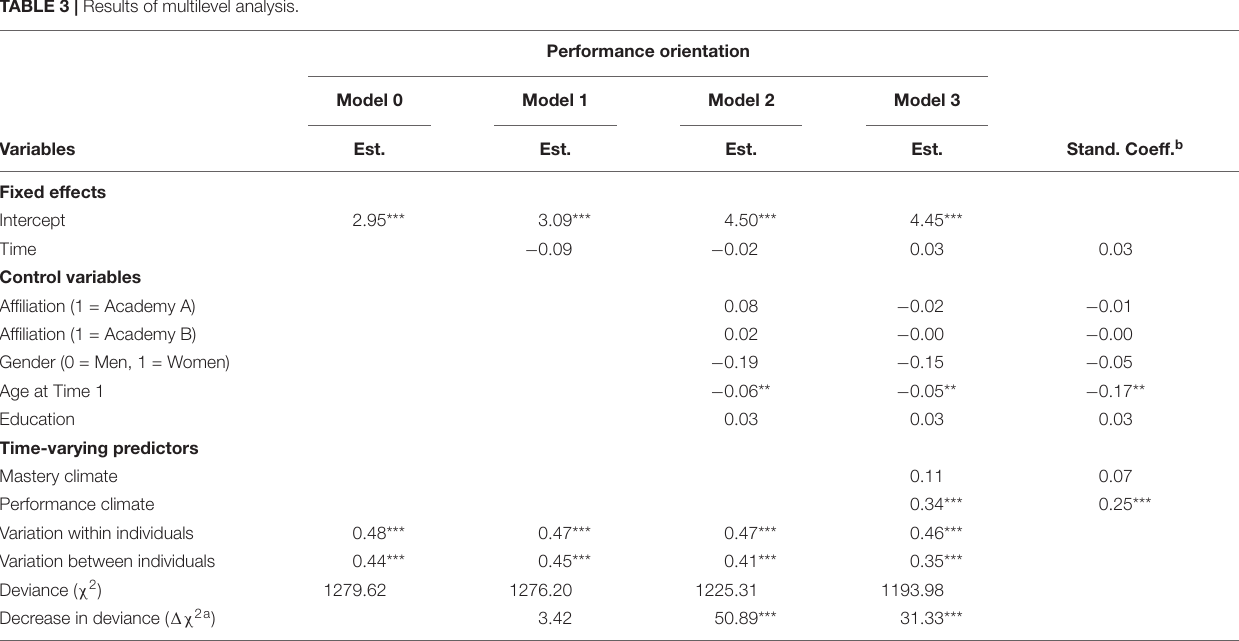
TABLE 3 | Results of multilevel